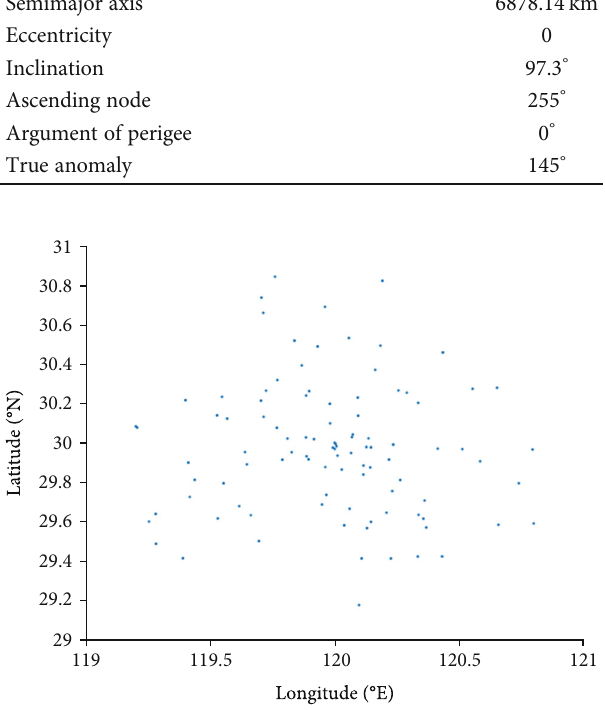
Figure 5: Ground targets randomly selected in the circular